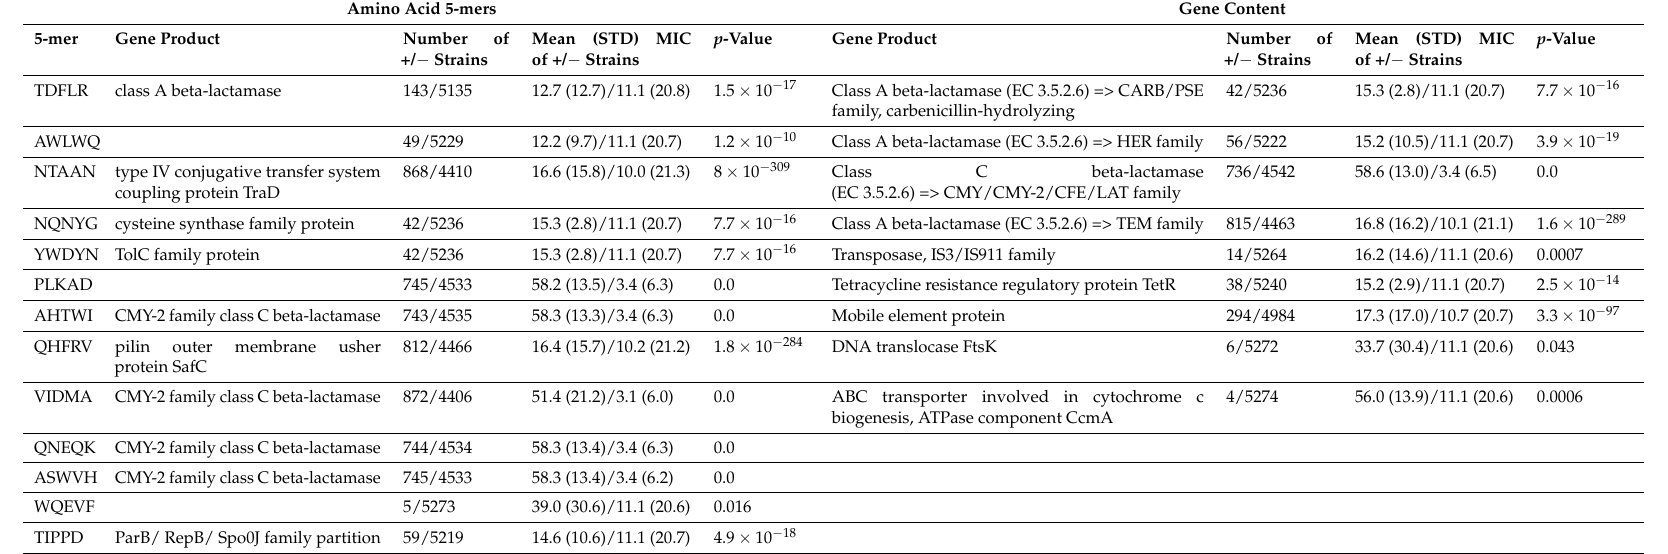
Table 2. Important genes found for S. enterica and amoxicillin clavulanic acid by amino acid 5-mer and gene content